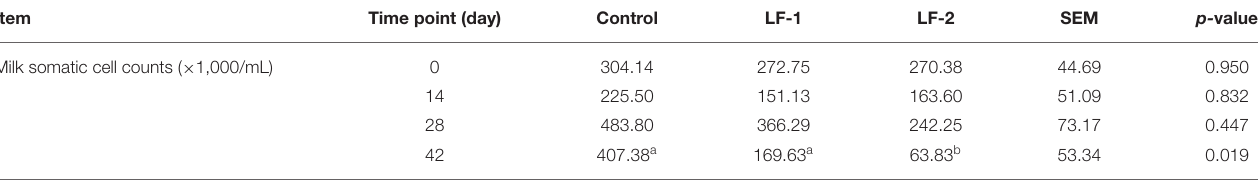
TABLE 5 | Effects of supplementation of BLFc at 100 mg/kg/day (LF-1) or 200 mg/kg/day (LF − 2) on milk somatic cell counts (SCCs) ( × 1,000/ml) in dairy goats. Item